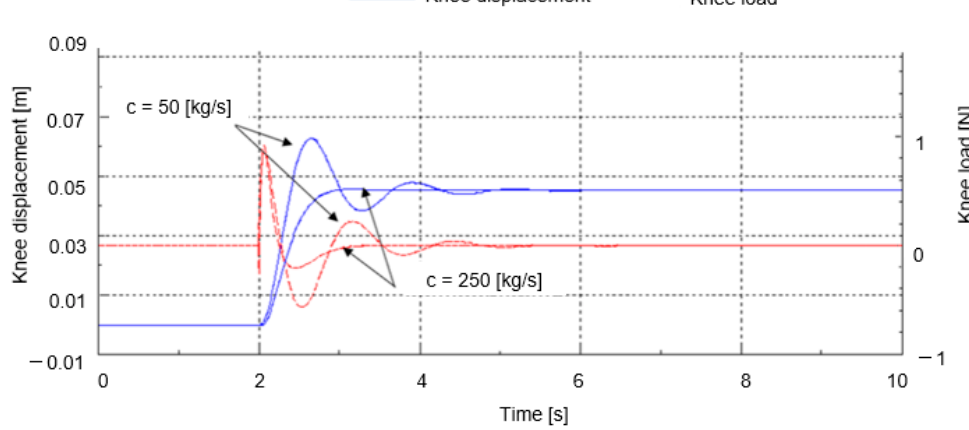
Figure 17. Comparison of device spring constant.